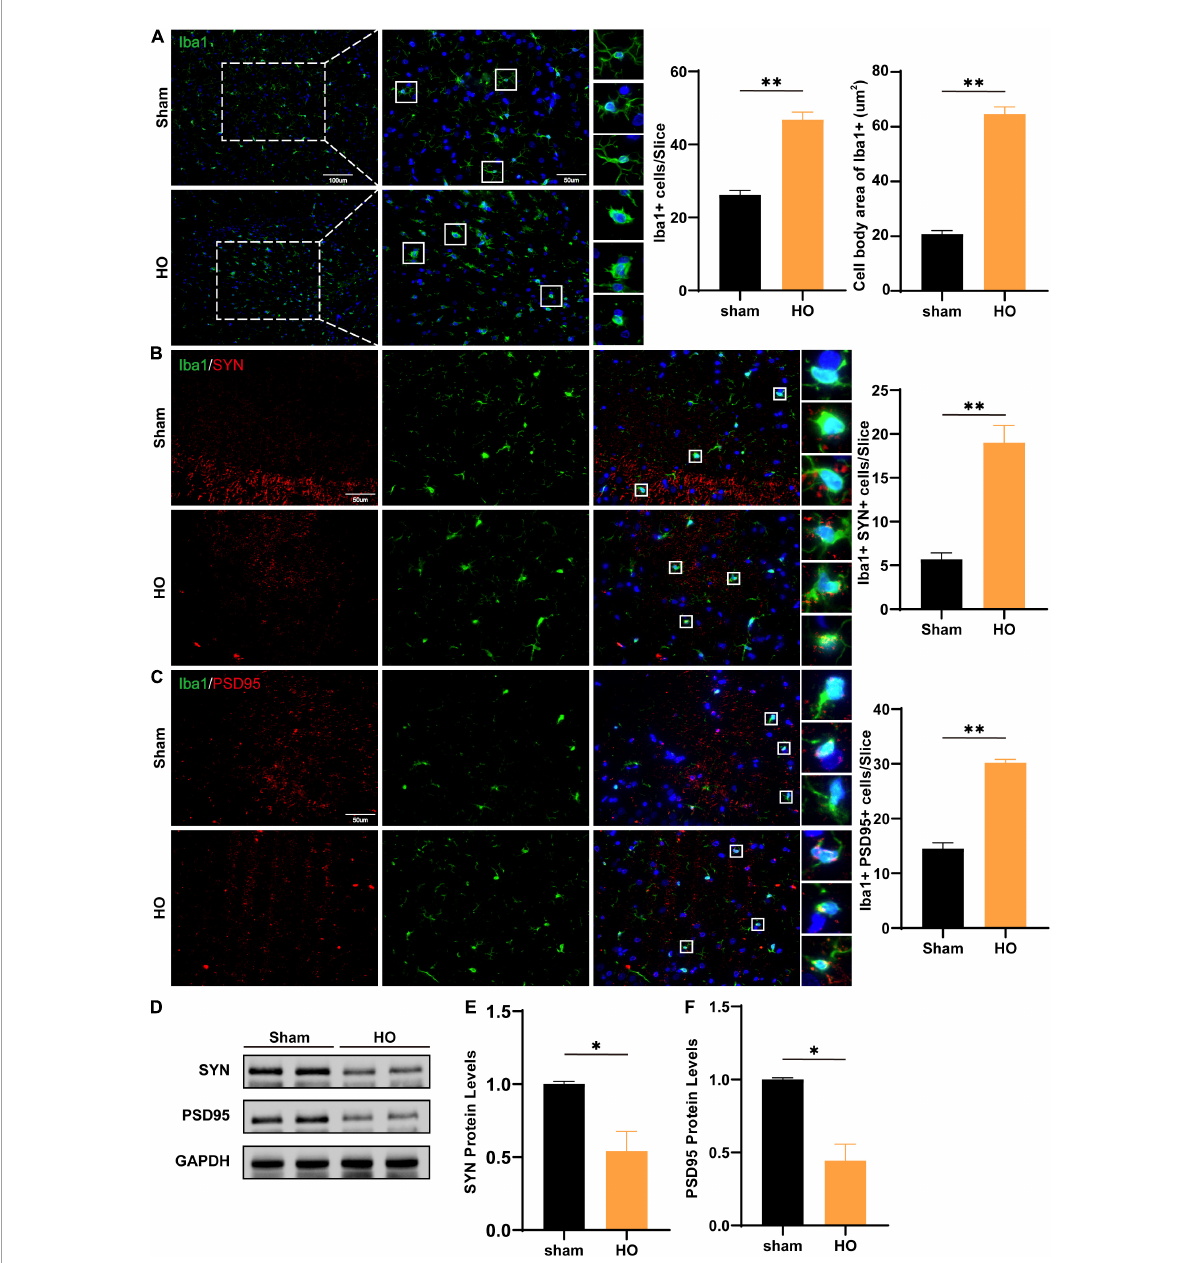
FIGURE5 Microglial cells and SYN/PSD95 protein in the hippocampal region of HO rats. (A) Immunofluorescence staining of Iba1 + cells. Iba1 (green) and DAPI (blue). Scale bars, 100 µ m for low magnification images and 50 µ m for high magnification images; quantification of Iba1 + cells and the cell body area in the hippocampus, n = 4–6, ∗∗ P < 0.01 vs. sham-operated group. (B) Immunofluorescence staining of Iba1 + and SYN in the hippocampus: SYN (red), Iba1 (green), and DAPI (blue); scale bars, 50 µ m, n = 6, ∗∗ P < 0.01 vs. sham-operated group. (C) Immunofluorescence staining of Iba1 + and PSD95 in the hippocampus: PSD95 (red), Iba1 (green), and DAPI (blue); scale bars, 50 µ m, n = 6, ∗∗ P < 0.01 vs. sham-operated group. (D–F) The protein levels of SYN and PSD95 in the hippocampus, n = 3, ∗ P < 0.05 vs. sham-operated group. All data are presented as the M ± SEM of each